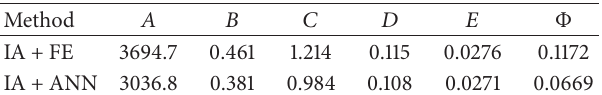
Table 10: Coefficients in (3) determined for the St3S steel using inverse analysis classical with the FE model and with the metamodel of the RC